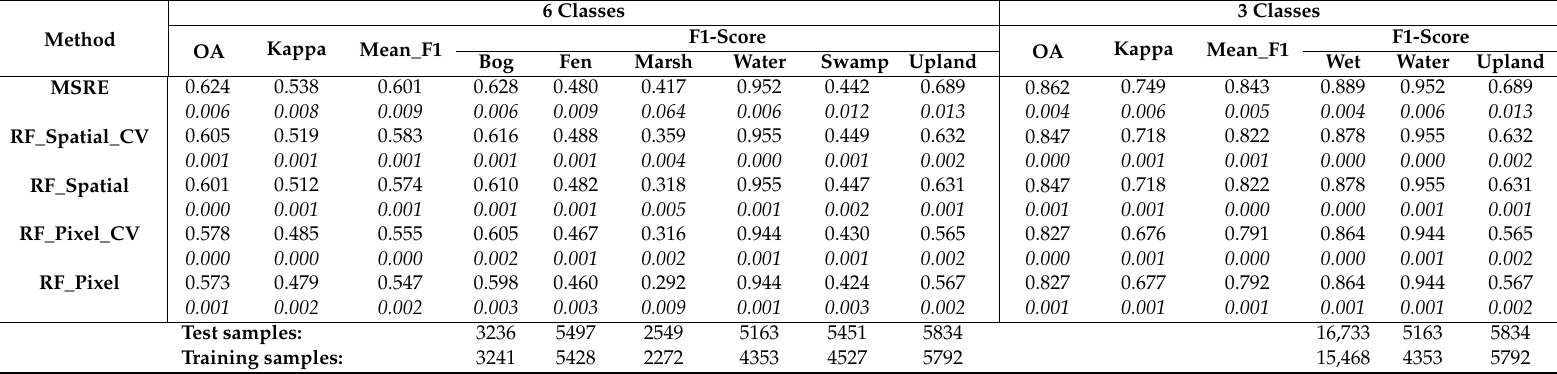
Table 1. ABMI_PP results including May and October composites for the spatial extension assessment and hold-out training convergence.